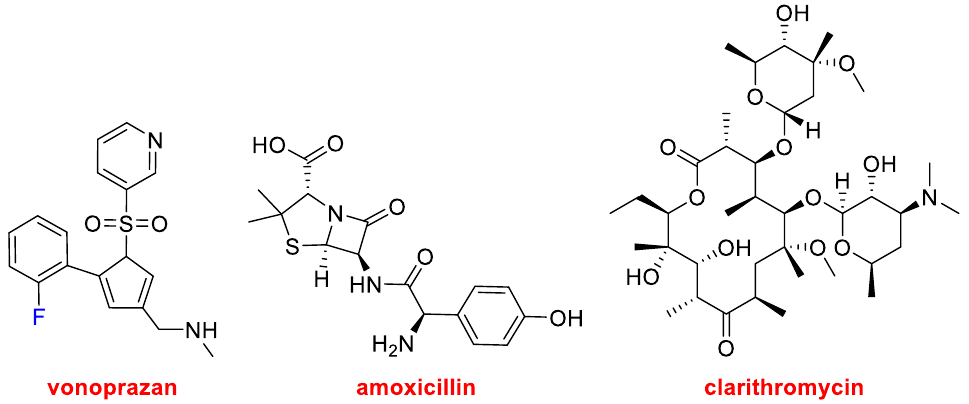
Figure 8. Structure of the components of the combination drug Voquezna™ Triple Pak™.